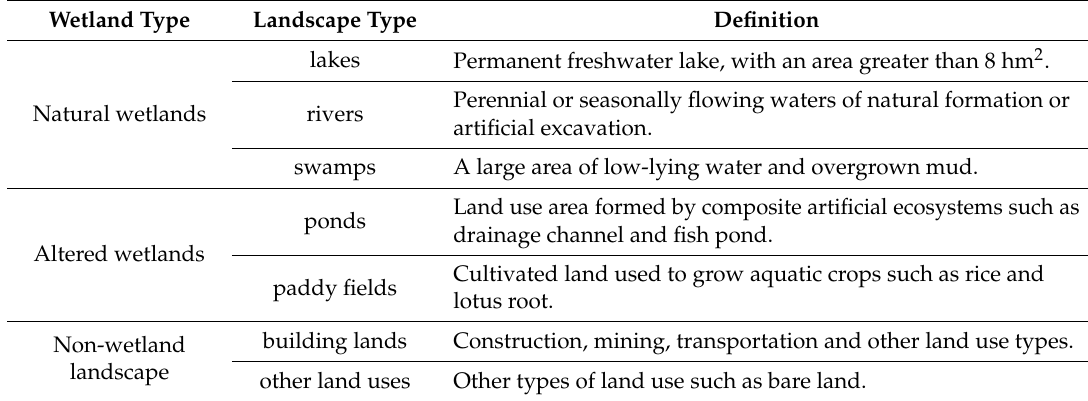
Figure 4. Landscape type classification map in the Nansi Lake Wetland (landscape changes in the years 1985, 1992, 2005, 2011, and 2017 are shown from left to right). Table 2. Classification and definition of landscape types in Nansi Lake.